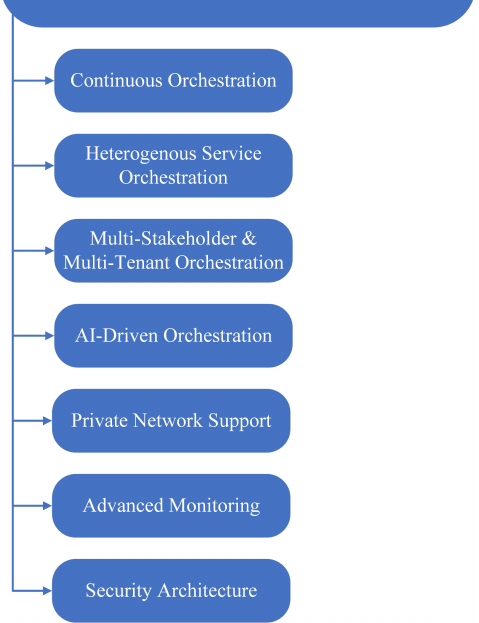
Figure 4. The 6G end-to-end network automation